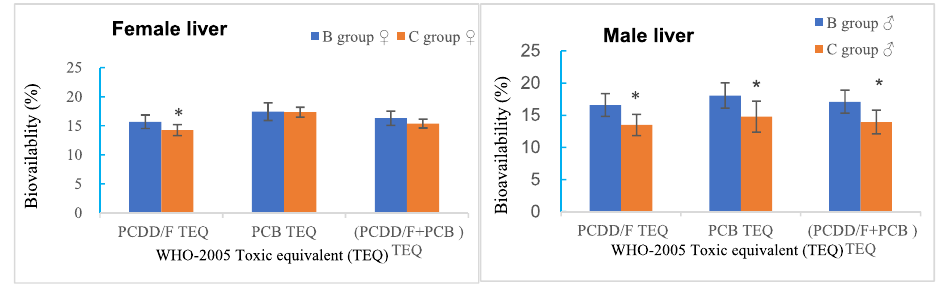
Figure 2. Effects of curcumin on bioavailability of WHO-TEQ 2005 (* p < 0.05) (drawn with Microsoft Excel).